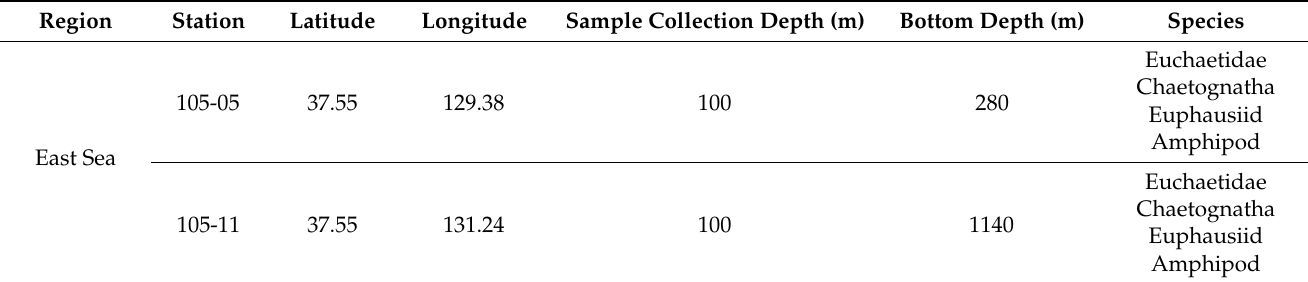
Figure 1. The sampling locations of the coastal (105-05) and offshore (105-11) regions during August Table 1. Information of sampling sites of this